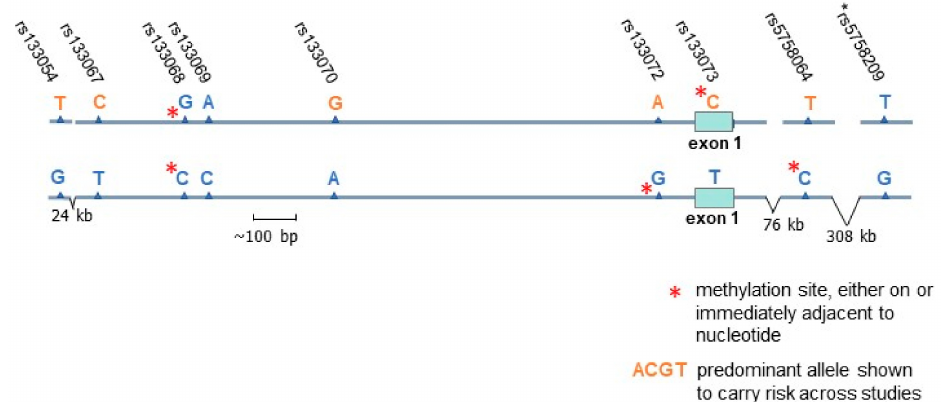
Figure 1. SNPs in linkage disequilibrium with the human MCHR1 gene that have been shown to exhibit various degrees of association with psychotic disorders, arranged as haplotypes with respect to rs133073 as determined by in silico analysis of the CEU population database (LDpop). Note that the allele of risk for *rs5758209 was not specified in the study by the Schizophrenia Working Group [68]. The alleles of risk from two small studies and one large study—in orange font—cluster on the upper haplotype and correspond to combined results from: a Scottish population, Severinsen et al. [62]: rs133068-70, -73; a Danish population, Demontis et al. [67]: rs133054-70, -72-73; a population of predominantly mixed European ancestry, Mullins et al. [69]: rs5758064; and a population of predomi- nantly mixed European ancestry, Schizophrenia Working Group [68]: *rs5758209. Where the risk data from the Scottish population and the Danish population did not match, both alleles are coded blue. The risk alleles identified in a Severinsen et al. study [62] for the far northern population isolate on the Faroe Islands, are shown on the lower in silico haplotype for rs133068-70,-73. A founder effect may have resulted in a higher prevalence of the C allele for rs133073 in the controls studied in this isolated population, 50% as compared to the rate the authors reported for Scotland (41%) and in current LDpop data for the UK (36%), but it is likely that the haplotype containing the T allele was selected for over time, with the evolutionary tradeoff being more schizophrenia cases, becoming markedly more prevalent (1.6-fold) in the Faroe Island cases than in